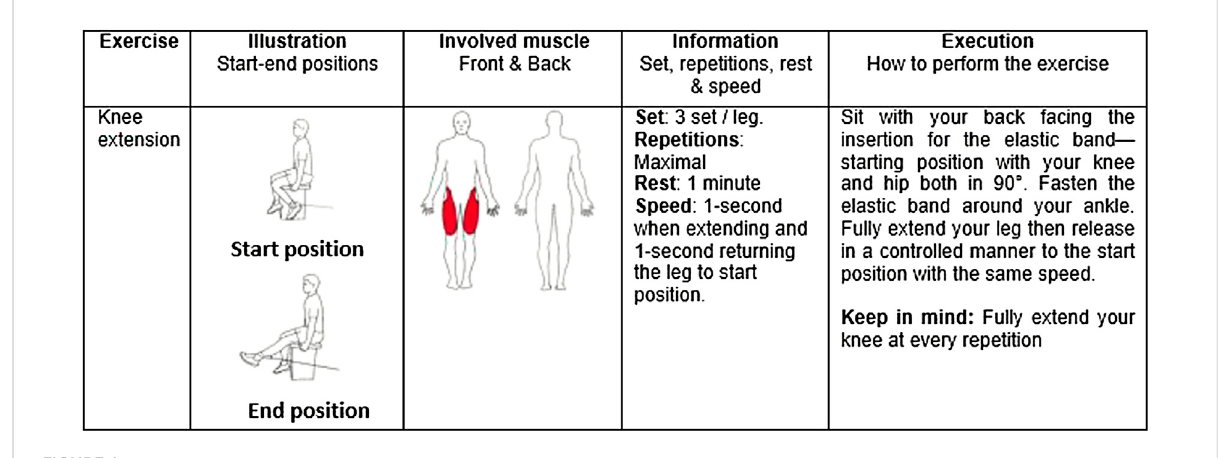
FIGURE 1 Description of the knee extension